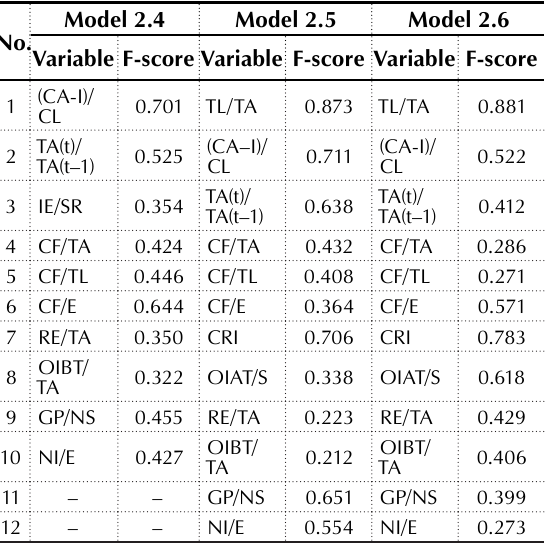
Table 5. Features selected in SVM models – variable set 2